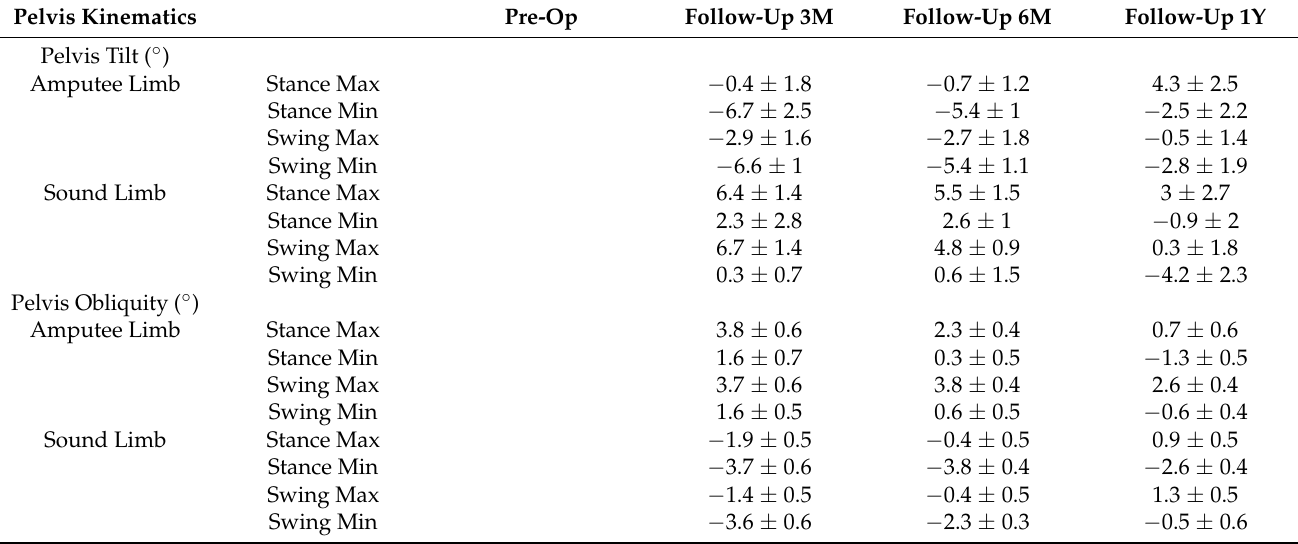
Table A4. Descriptive peak pelvis kinematics for the amputee and sound limb in the pre-operative gait analysis (socket-type prosthesis, ST) and the follow-up gait analyses (osseointegrated prosthesis, OI). Data are presented for the self-selected gait as mean ± standard deviation separately for stance and swing